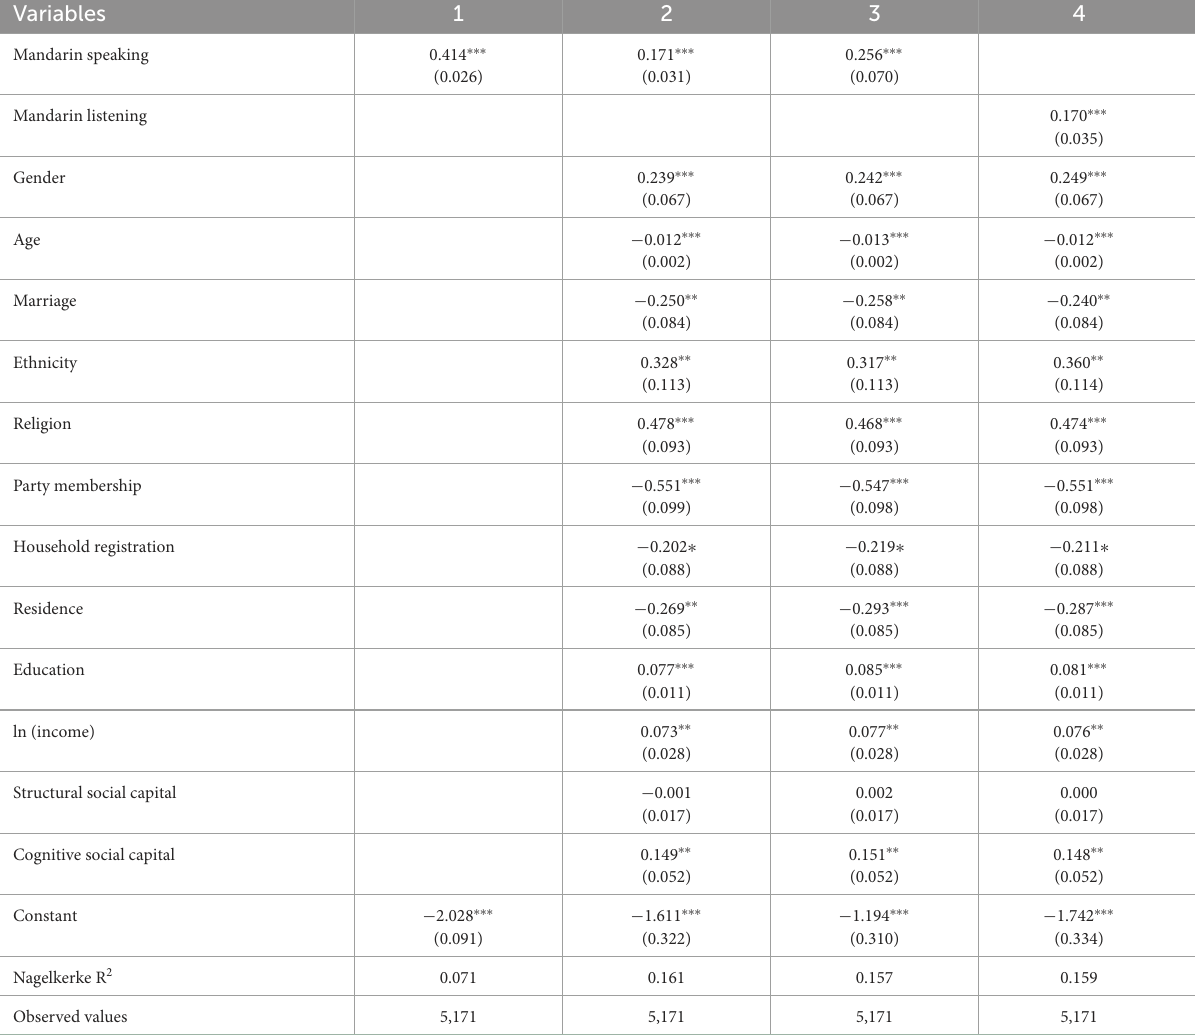
TABLE 2 Effect of Mandarin proficiency on donation behavior: Baseline regression ( N = 5,171).